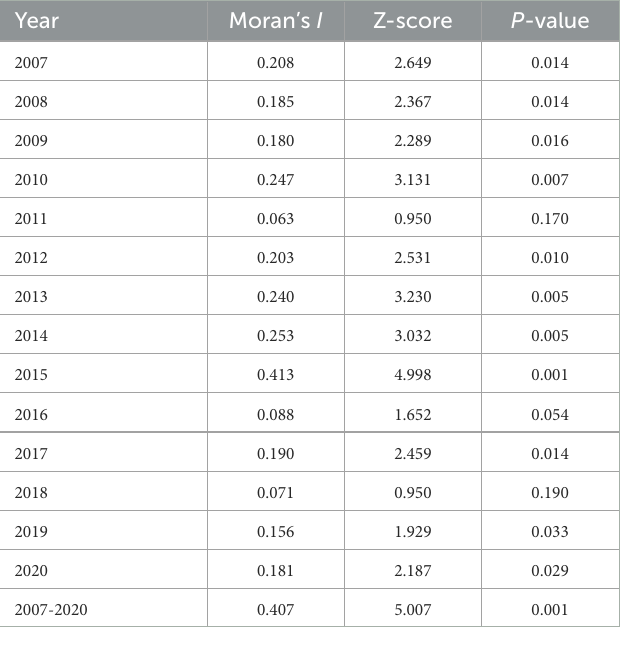
TABLE 3 Spatial autocorrelation analysis of notified PTB incidence among students in Zhejiang Province.